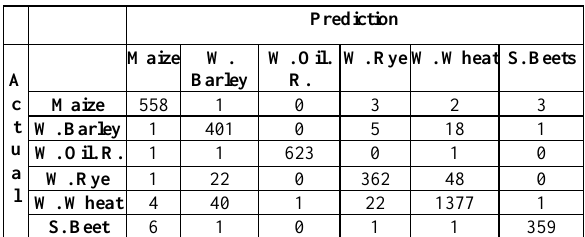
Table 6. Confusion matrix for DL with SSL pretraining under temporal and spatial